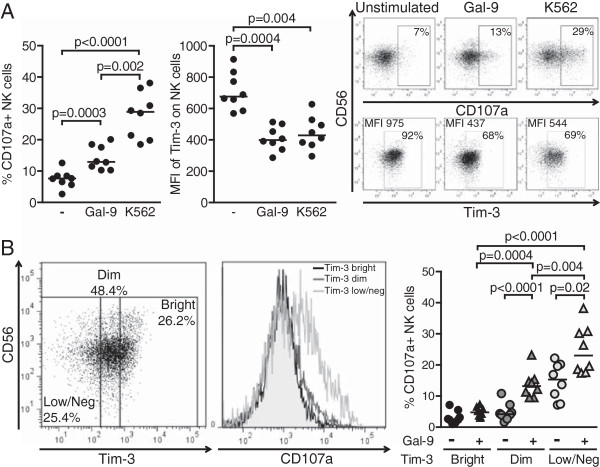
Incubation with soluble Gal-9 increases NK cell function and decreases surface expression of Tim-3. (A) Dot plots represent the percentages of CD107a + NK cells and the MFI of Tim-3 on NK cells from 8 healthy individuals upon pre-activation with 1 ng/mL of IL-15 and IL-18 overnight followed by stimulation with either 0.9 μg/mL of soluble Gal-9 for another 16 h or K562 target cells at an effector:target ratio of 10:1 for 6 h. Representative primary flow cytometry panels show CD107a upregulation (upper panel) and Tim-3 expression (lower panel) on NK cells that were left unstimulated, or were activated as indicated. (B) Unstimulated or Gal-9-activated NK cells were divided into Tim-3bright, Tim-3dim and Tim-3low/neg so that the bright and the low/neg subpopulations each consistently represents about 25% of the bulk NK cells, and subsequently analyzed for CD107a expression. Representative primary flow panel shows an example of subdivision of NK cells according to Tim-3 expression. Percentages of positive NK cells and median fluorescence intensity are indicated. Histograms display CD107a upregulation in each subset following incubation with soluble Gal-9. Horizontal lines indicate the median percentages. Statistically significant difference reached when p < 0.05 is indicated.